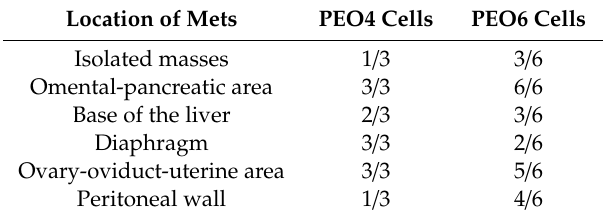
Table 2. Most frequent areas colonized upon i.p. administration of HGSOC cells. Location of Mets PEO4 Cells PEO6 Cells Isolated